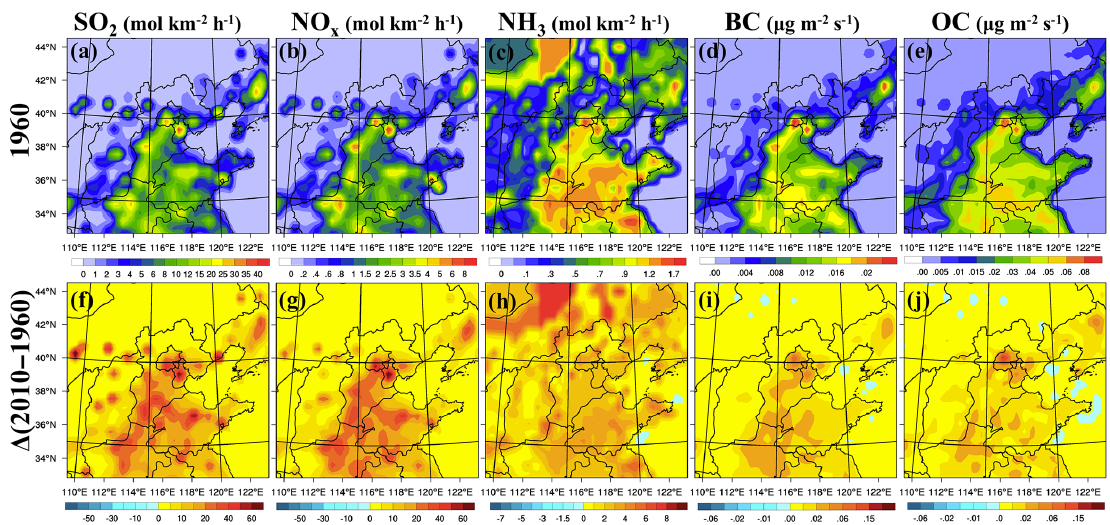
Figure 1. SO 2 , NO x , NH 3 , BC, and OC emissions for year 1960 (a – e) and their changes from 1960 to 2010 (f – j)